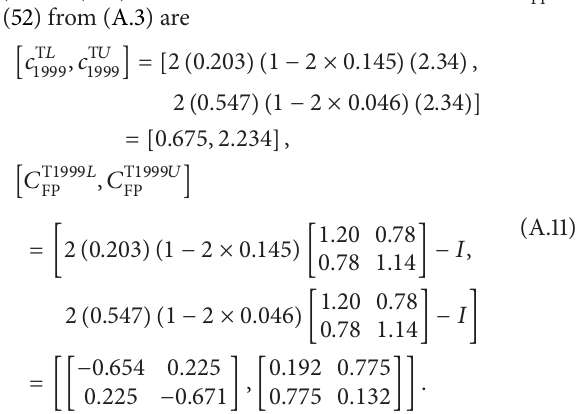
Table 3, the bounds of 𝛽 P 1997 = 1.739 are [𝛽 P 𝐿 1997 , 𝛽 P 𝑈 1997 ]